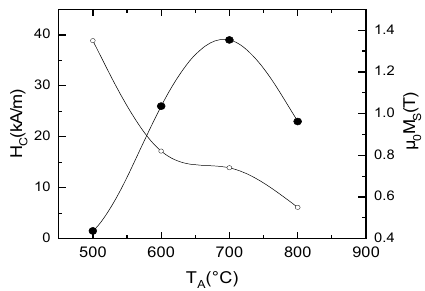
Figure 11. Coercive fields and saturation magnetization values obtained for the annealed samples, as a function of annealing temperature.